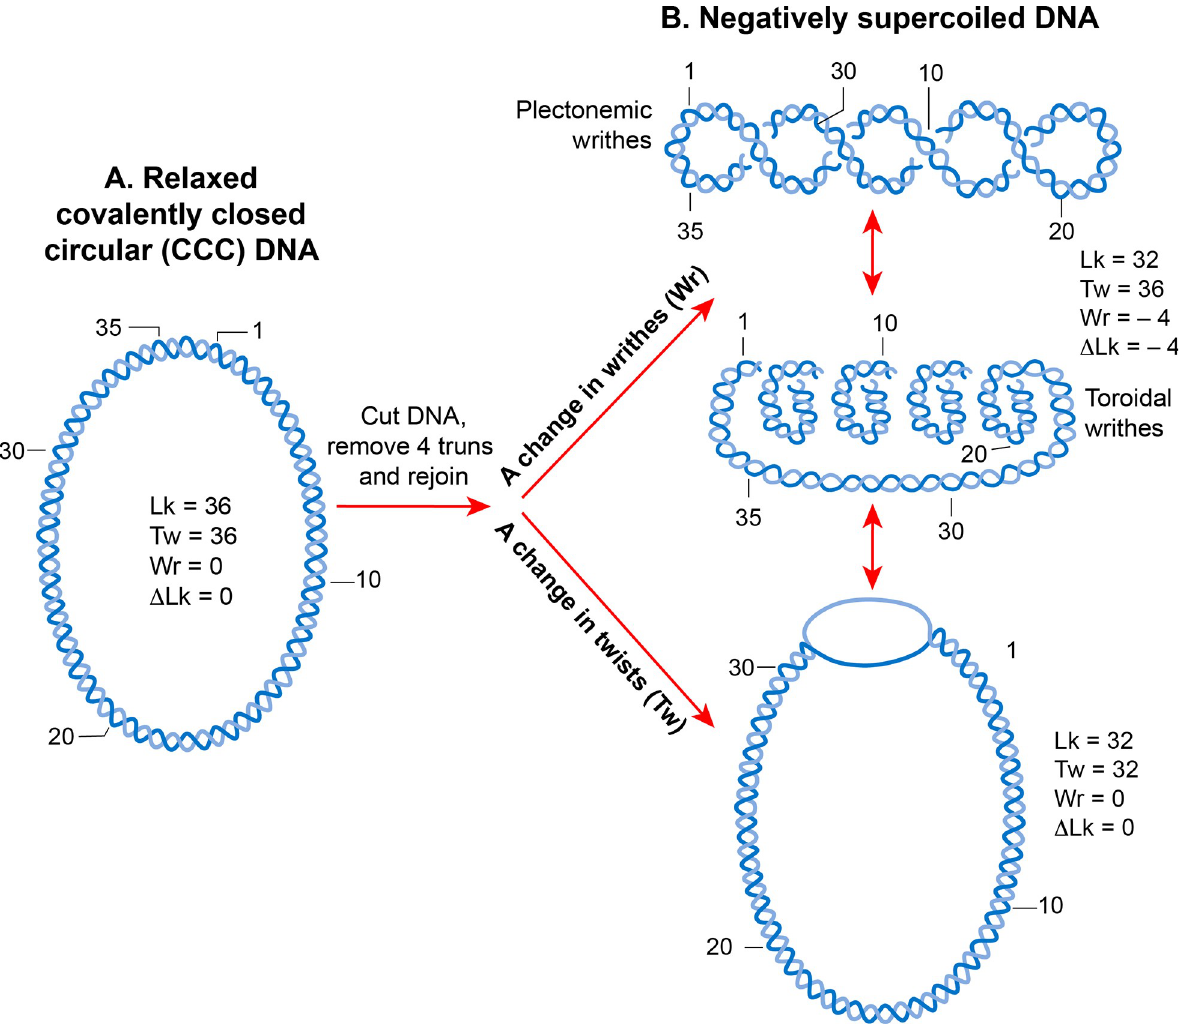
Fig 4. DNA supercoiling. A. A linear double-stranded DNA becomes a topologically constrained molecule if the two ends are covalently joined, forming a circle. Rules of DNA topology are explained using such a molecule (ccc-DNA) in which a numerical parameter called the linking number (Lk) defines the topology. Lk is a mathematical sum of two geometric parameters, twist (Tw) and writhe (Wr). A twist is the crossing of two strands, and writhe is coiling of the DNA double helix on its axis that requires bending. Lk is always an integer and remains invariant no matter how much the two strands are deformed. It can only be changed by introducing a break in one or both DNA strands by DNA metabolic enzymes called topoisomerases. B. A torsional strain created by a change in Lk of a relaxed, topologically constrained DNA manifests in the form of DNA supercoiling. A decrease in Lk (Lk < Lk 0 ) induces negative supercoiling whereas an increase in Lk (Lk > Lk 0 ) induces positive supercoiling. Only negative supercoiling is depicted here. For example, if a cut is introduced into a ccc-DNA and four turns are removed before rejoining the two strands, the DNA becomes negatively supercoiled with a decrease in the number of twists or writhe or both. Writhe can adopt two types of geometric structures called plectoneme and toroid. Plectonemes are characterized by the interwinding of the DNA double helix and an apical loop, whereas spiraling of DNA double helix around an axis forms